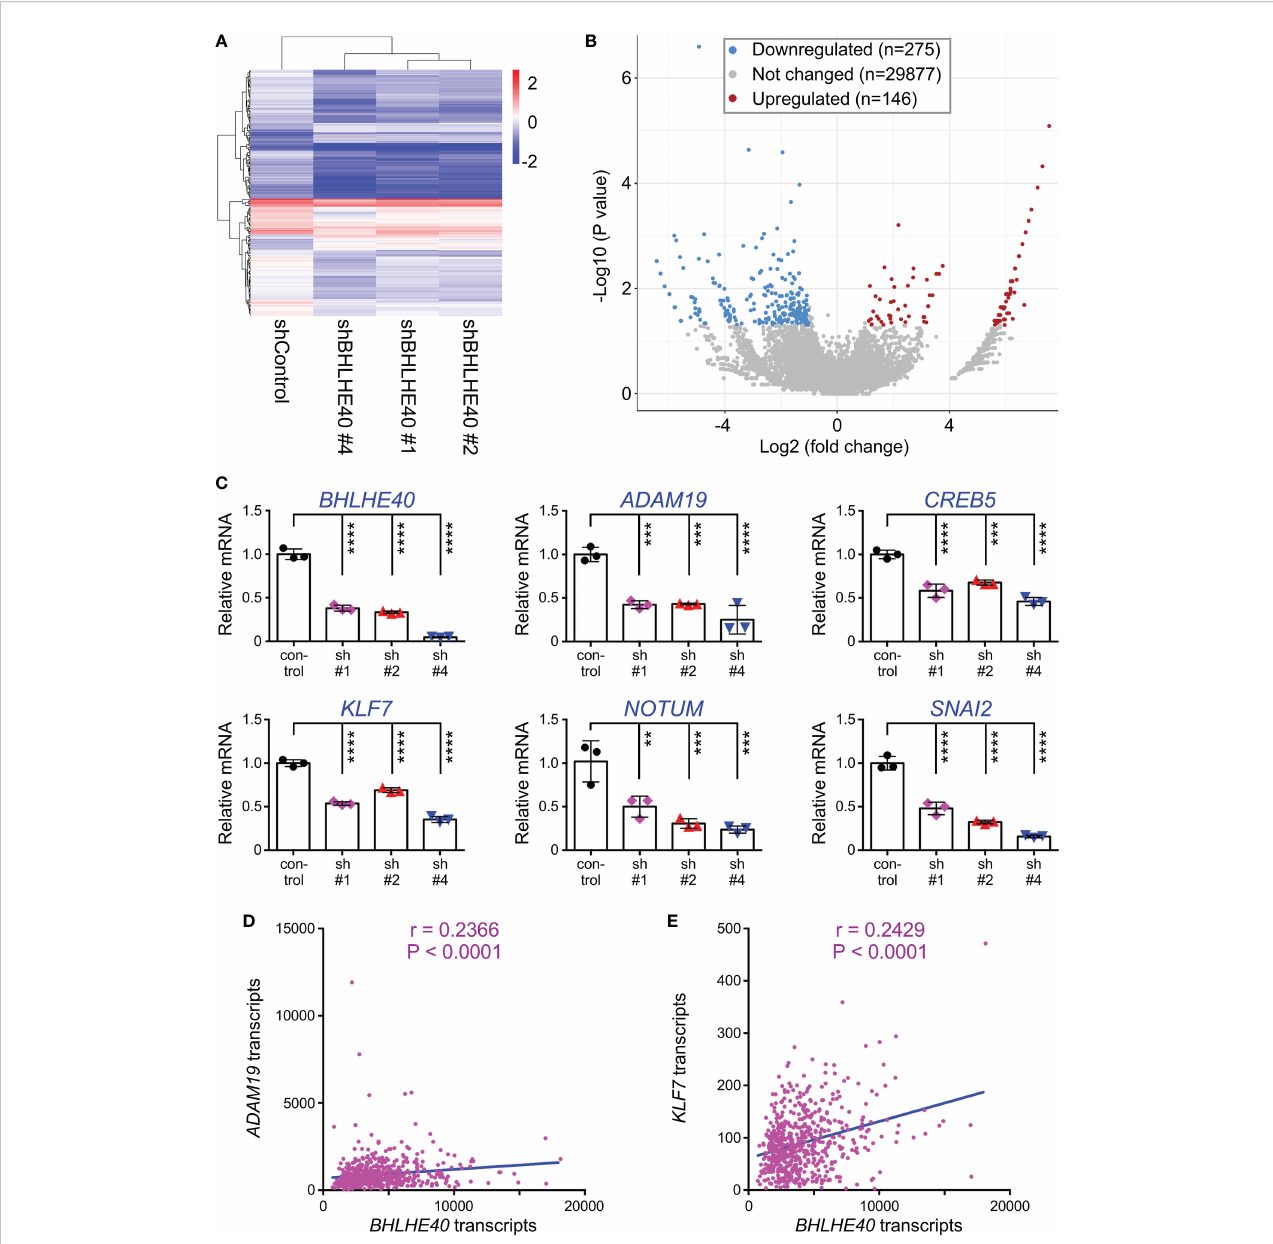
FIGURE 6 Transcriptome changes upon BHLHE40 downregulation. (A) Heat map of transcript changes between control HCT116 cells and those with downregulation of BHLHE40. (B) Volcano plot showing average P values versus average fold changes. Only genes with absolute transcript level changes of greater than 2 and P<0.05 were considered up- or downregulated. (C) Validation by quantitative RT-PCR for indicated transcripts that were found downregulated upon expression of BHLHE40 shRNAs. All mRNA levels were normalized to GAPDH . One-way ANOVA (Dunnett ’ s multiple comparisons test; n=3); **P < 0.01; ***P < 0.001; ****P < 0.0001. (D) Correlation of BHLHE40 mRNA levels with those of ADAM19 in 592 colorectal adenocarcinomas. Data were derived from the TCGA PanCancer Atlas (RSEM values; batch normalized from Illumina HiSeq_RNASeqV2); r=Spearman correlation coef fi cient. (E) Analogous for KLF7